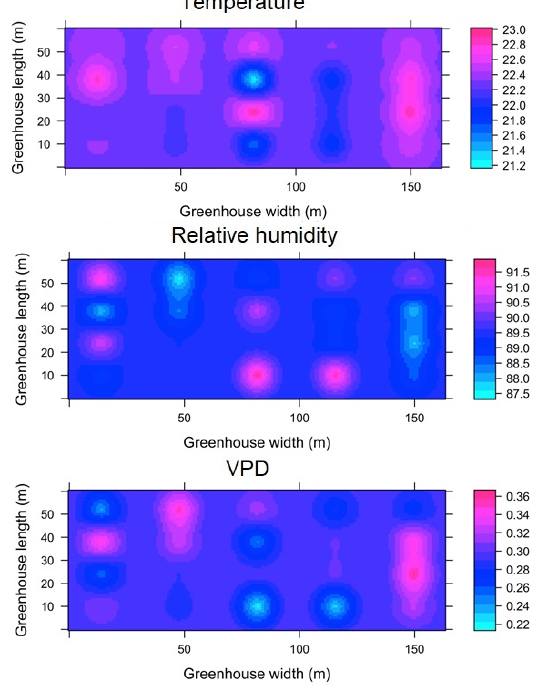
20 of 31 Figure 13. Spatial distribution predicted by kriging, for temperature, relative humidity and VPD